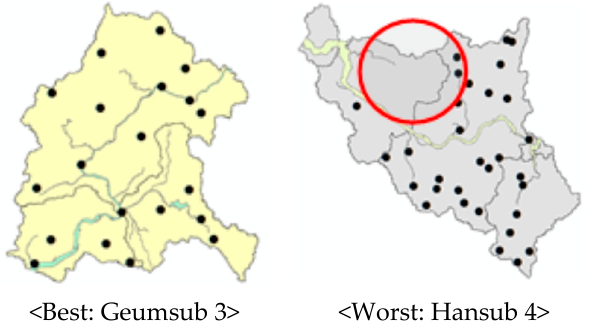
Figure 4. Spatial Distribution of Rain Gauge Network Based on NNI (Best and Worst Sub-basin).